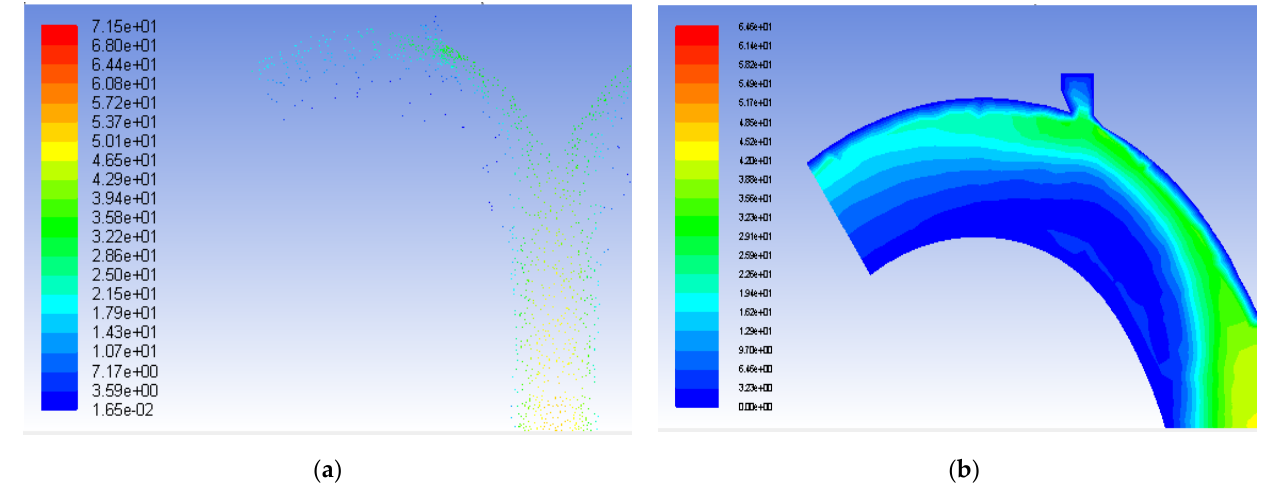
Figure 8. Distributor air flow analysis diagram. ( a ) Airflow velocity and flow field distribution; ( b ) Airflow velocity vector.